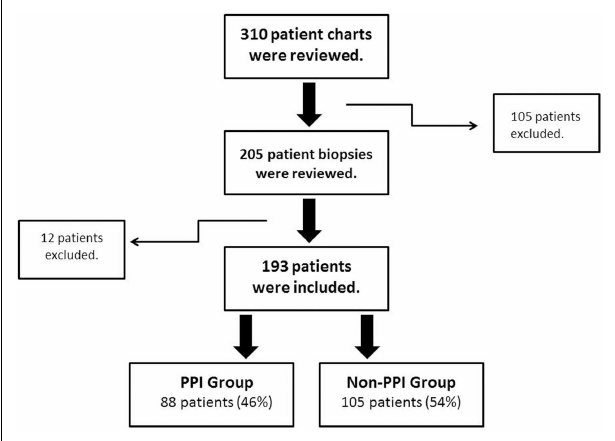
FIGURE 1 | Patient inclusion and exclusion algorithm . Flow chart of the inclusion/exclusion criteria. PPI, proton pump inhibitors.